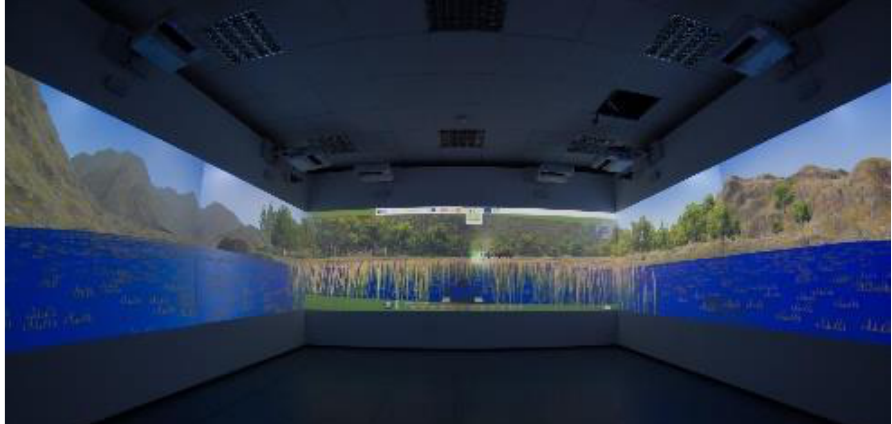
Figure 17. An immersive environment for XR applications.